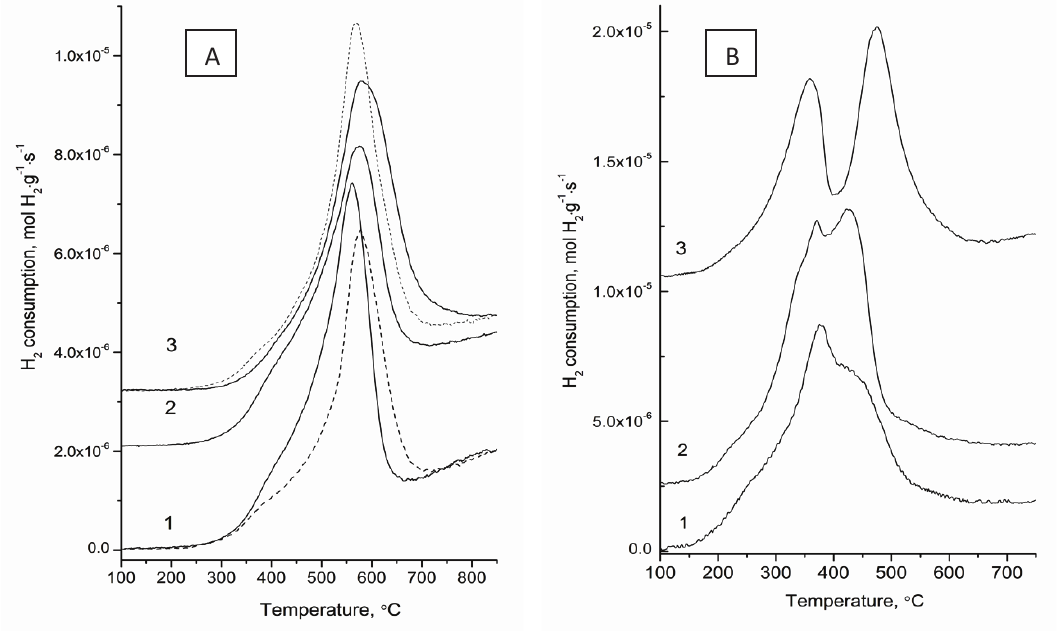
Zr O catalysts (B): 1 – B2 x 1-x 2